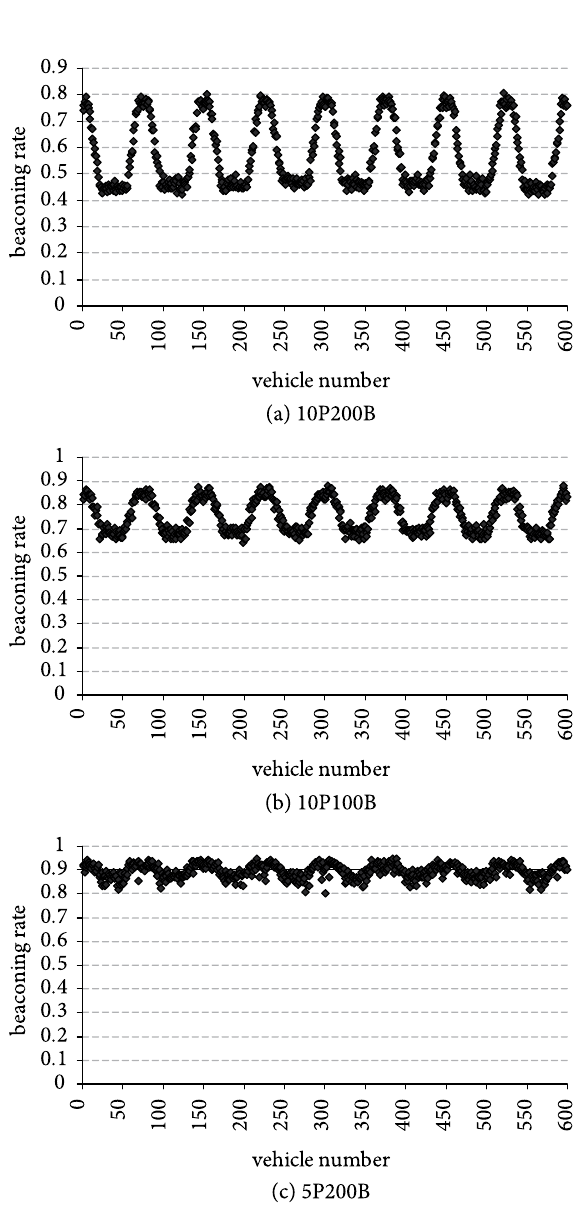
Fig. 4. Beaconing rate of vehicles in different scenarios (transmission range = 150